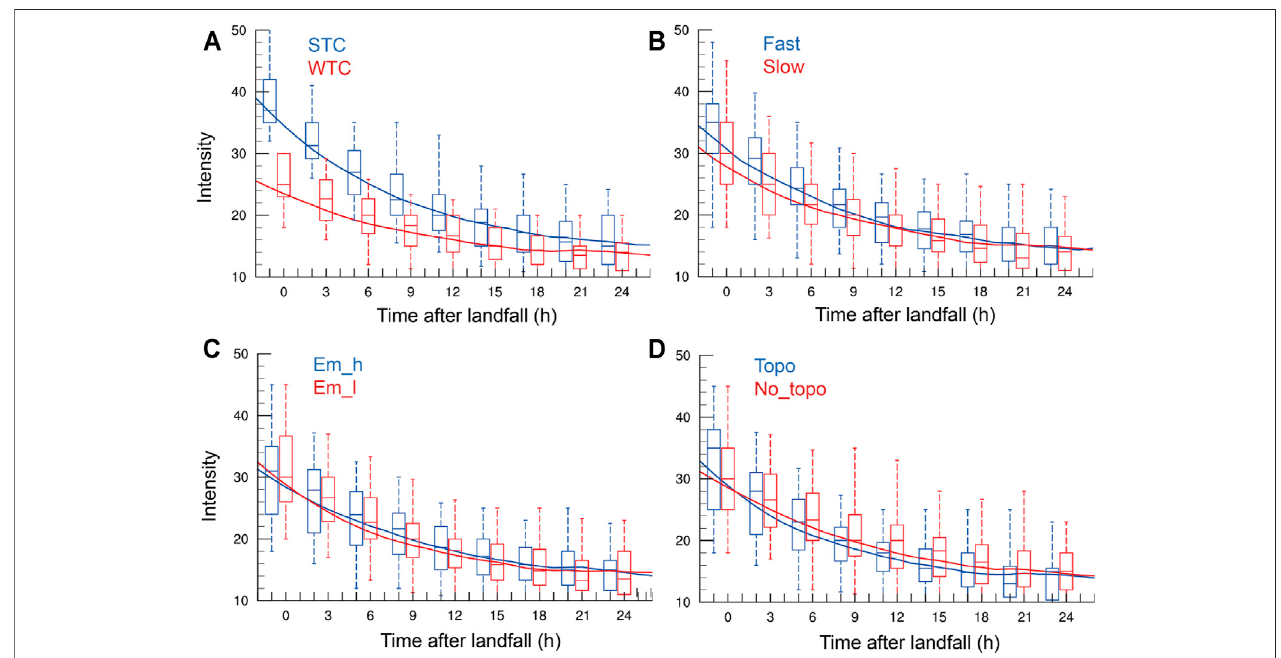
FIGURE7| Asin Figure3B ,butfor (A) STC(blue)vs.WTC(red), (B) Fast(blue)vs.Slow(red), (C) Em_h(blue)vs.Em_l(red),and (D) Topo(blue)vs.No_topo(red), see text for details.